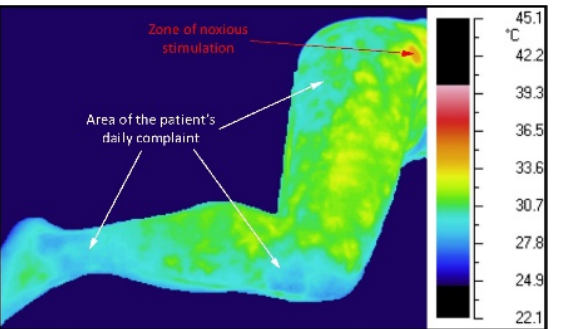
Figure 1. An example of the SP test thermogram with the area of the gluteus minimus noxious stimulation (red arrow) and the lower leg areas associated with the patient’s daily complaint and observed towards vasomotor response using an infrared thermal camera (white arrows) .